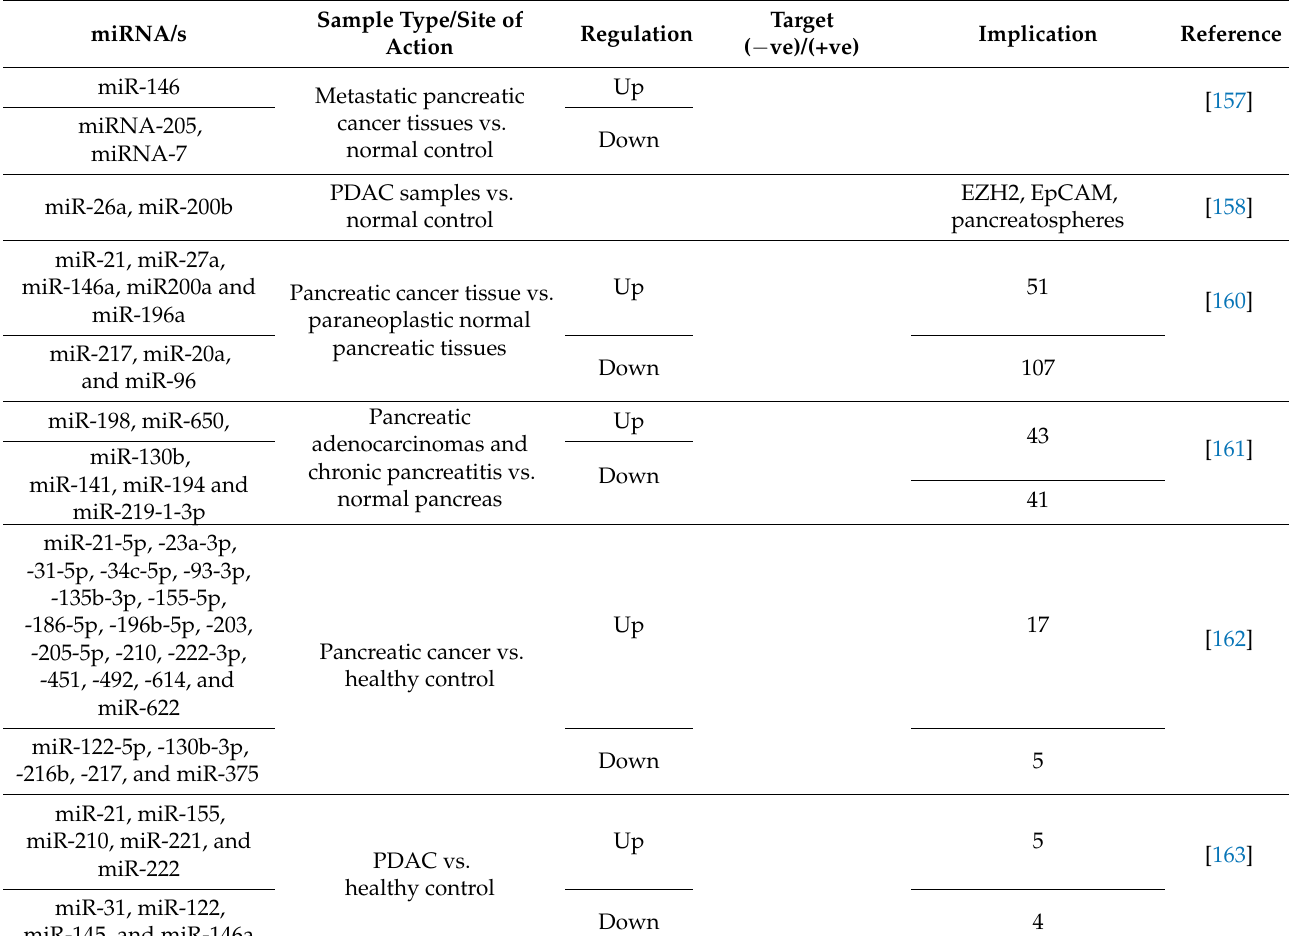
Table 3. Summary of differentially expressed microRNAs and their targets in pancreatic cancer. Sample Type/Site of miRNA/s Regulation Action miR-146 Metastatic pancreatic cancer tissues vs. Down normal control PDAC samples